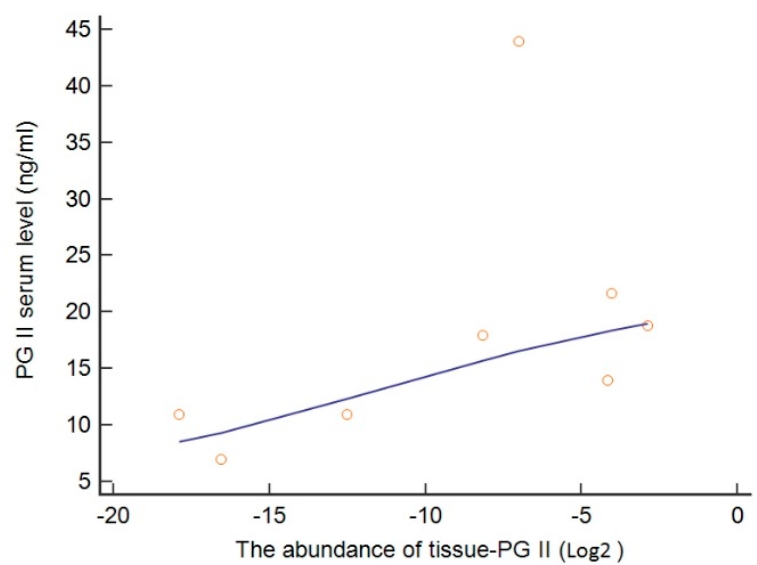
Figure 4. Positive relationship between serum PGII levels and abundance of PGII from the paired patient samples.